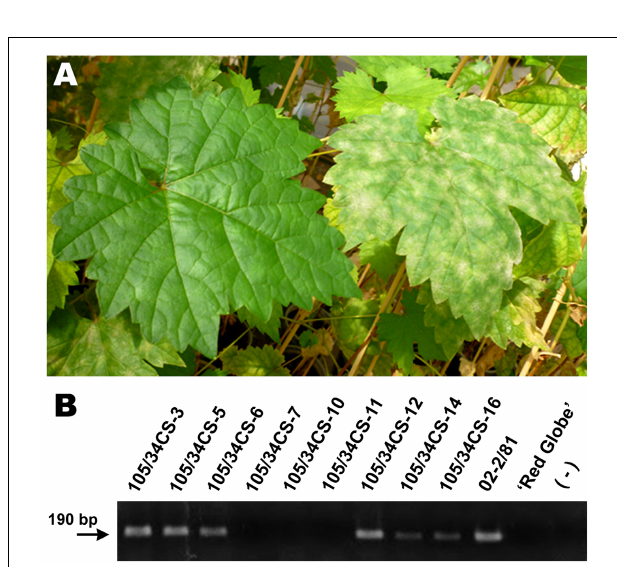
FIGURE 1 | Molecular characterization of Erysiphe necator in monosporangial cultures through single nucleotide polymorphism of β -tubulin gene. (A) In vitro establishment of E. necator isolates in Vitis vinifera leaves in a dual culture technique. (B) Microscopic visualization of chains of E. necator conidia suitable for monosporangial culture. (C) Identification of the E. necator genetic group B using cleaved amplified polymorphic sequence method. En: isolate of E. necator ; Acc I: restriction endonuclease; digestion by Acc I into two DNA fragments indicates the presence of group B isolate.